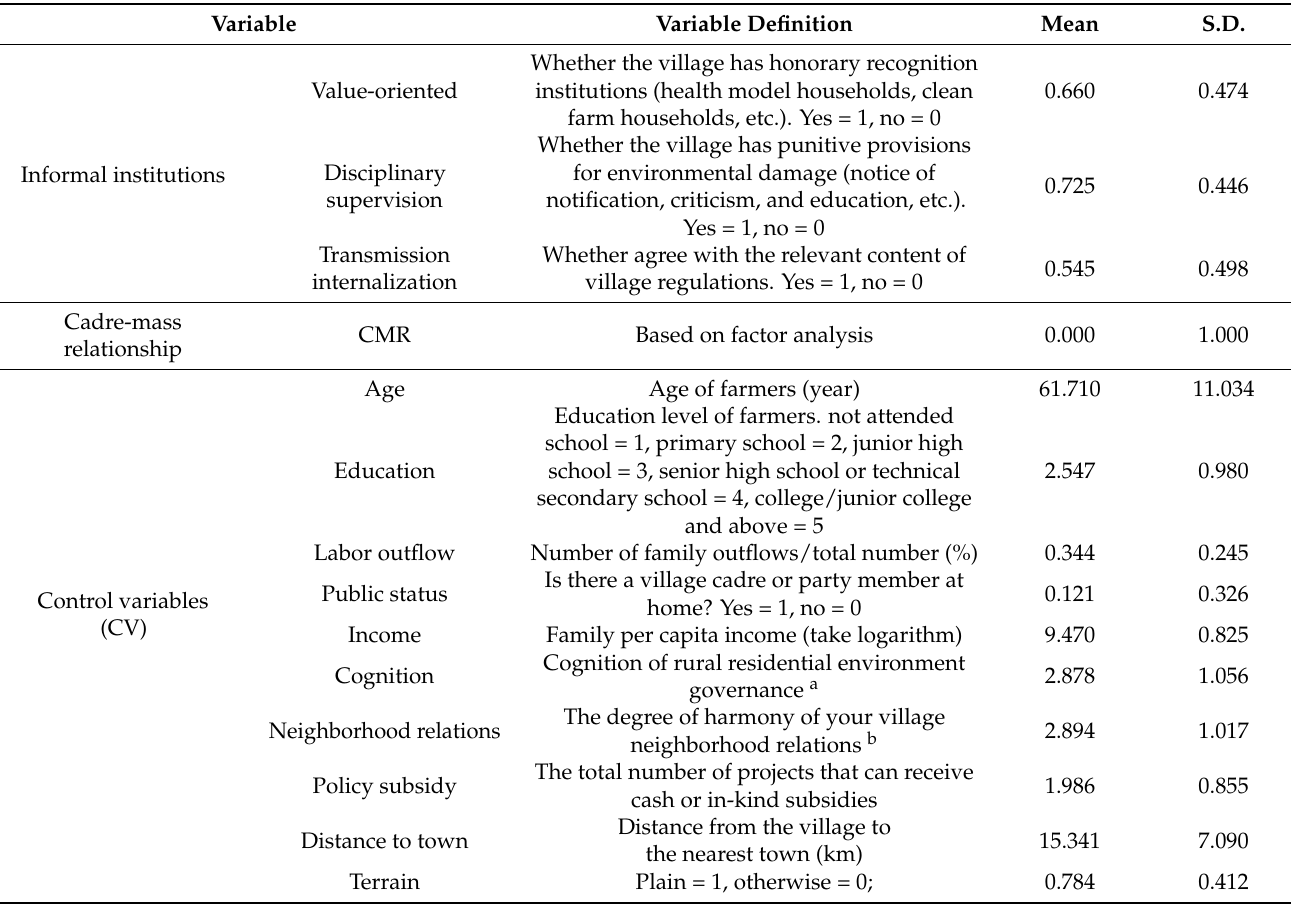
Table 3. Variable definition and descriptive